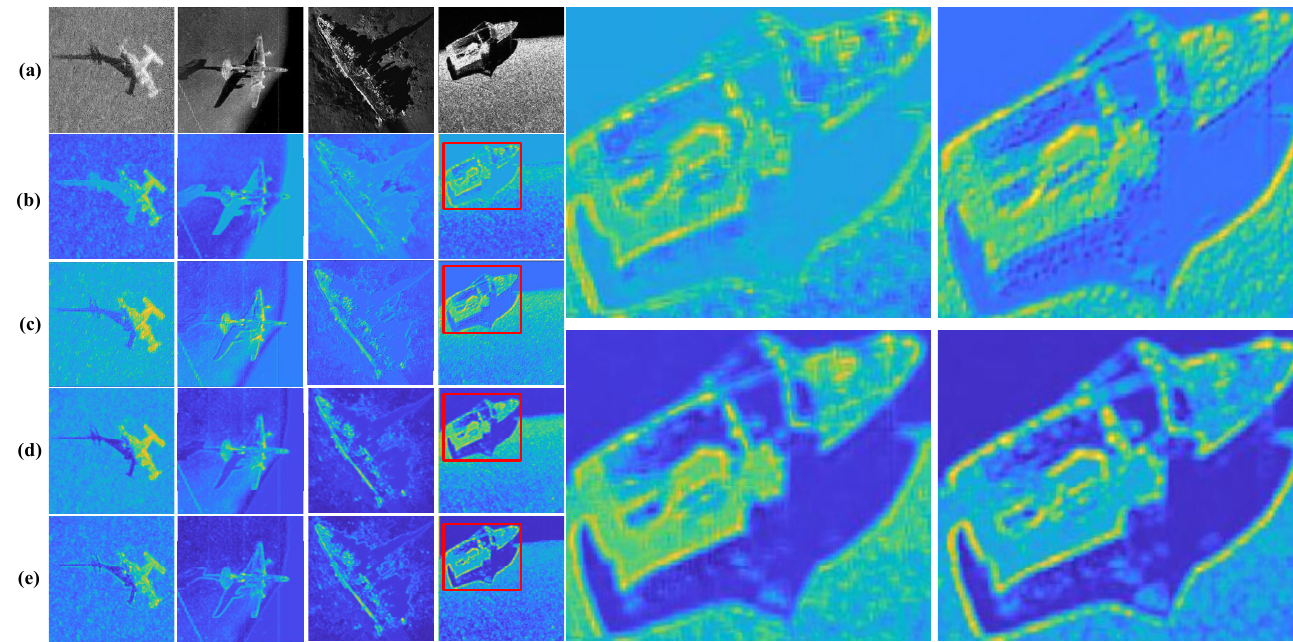
Figure 11. Comparison of feature response maps for different models: ( a ) SSS image samples; ( b ) Pre-trained VGG19 using ImageNet; ( c ) Retrain the pre-trained VGG19; ( d ) VGG19 transfer learned from SAR dataset; ( e ) VGG19 with MSRAM after transfer learning. The four images on the right are partial enlargements within the red box.